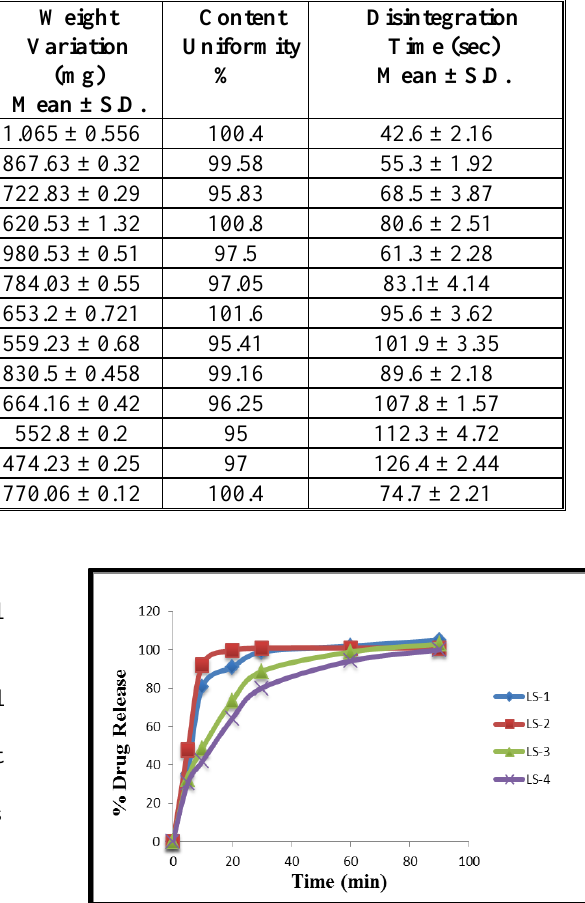
Table 4. Evaluation parameters of clopidogrel bisulfate liquisolid compact